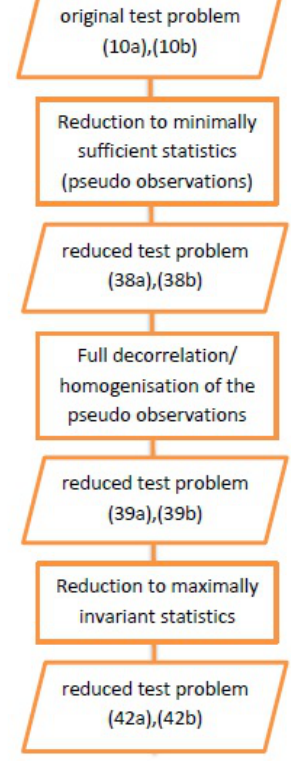
Figure 2: Flow chart of the derivation in section